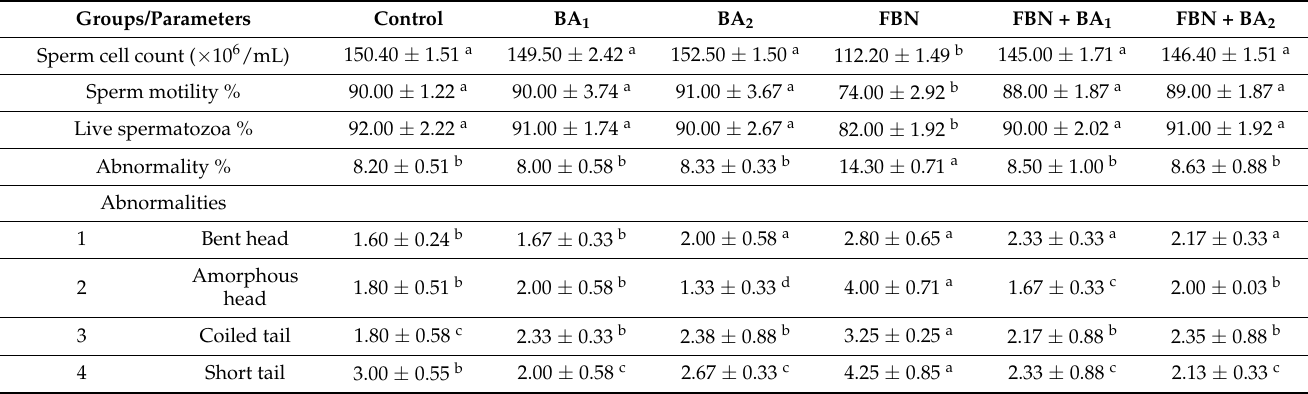
Table 4. The effect of fipronil (FPN) and co-treatment with boswellic acid (BA) on semen analysis. Groups/Parameters